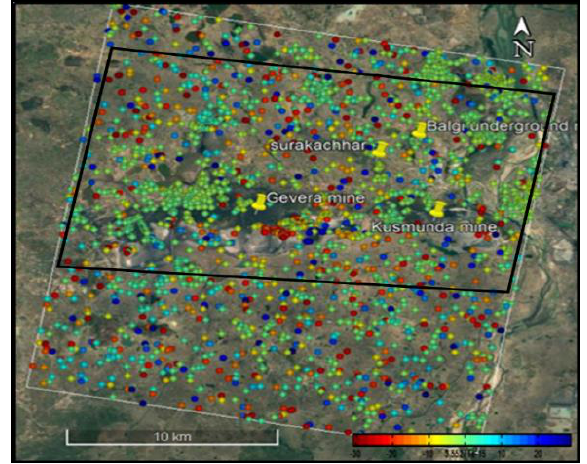
Figure 3 Resampled map of the total processed area and in black color rectangle is mine’s area under observation.